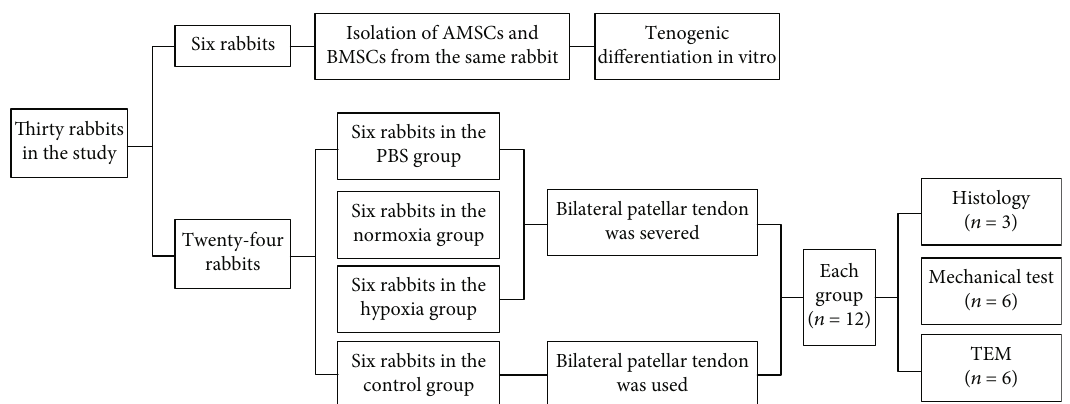
Figure 1: Schematic fl ow chart of experimental design and groups of the